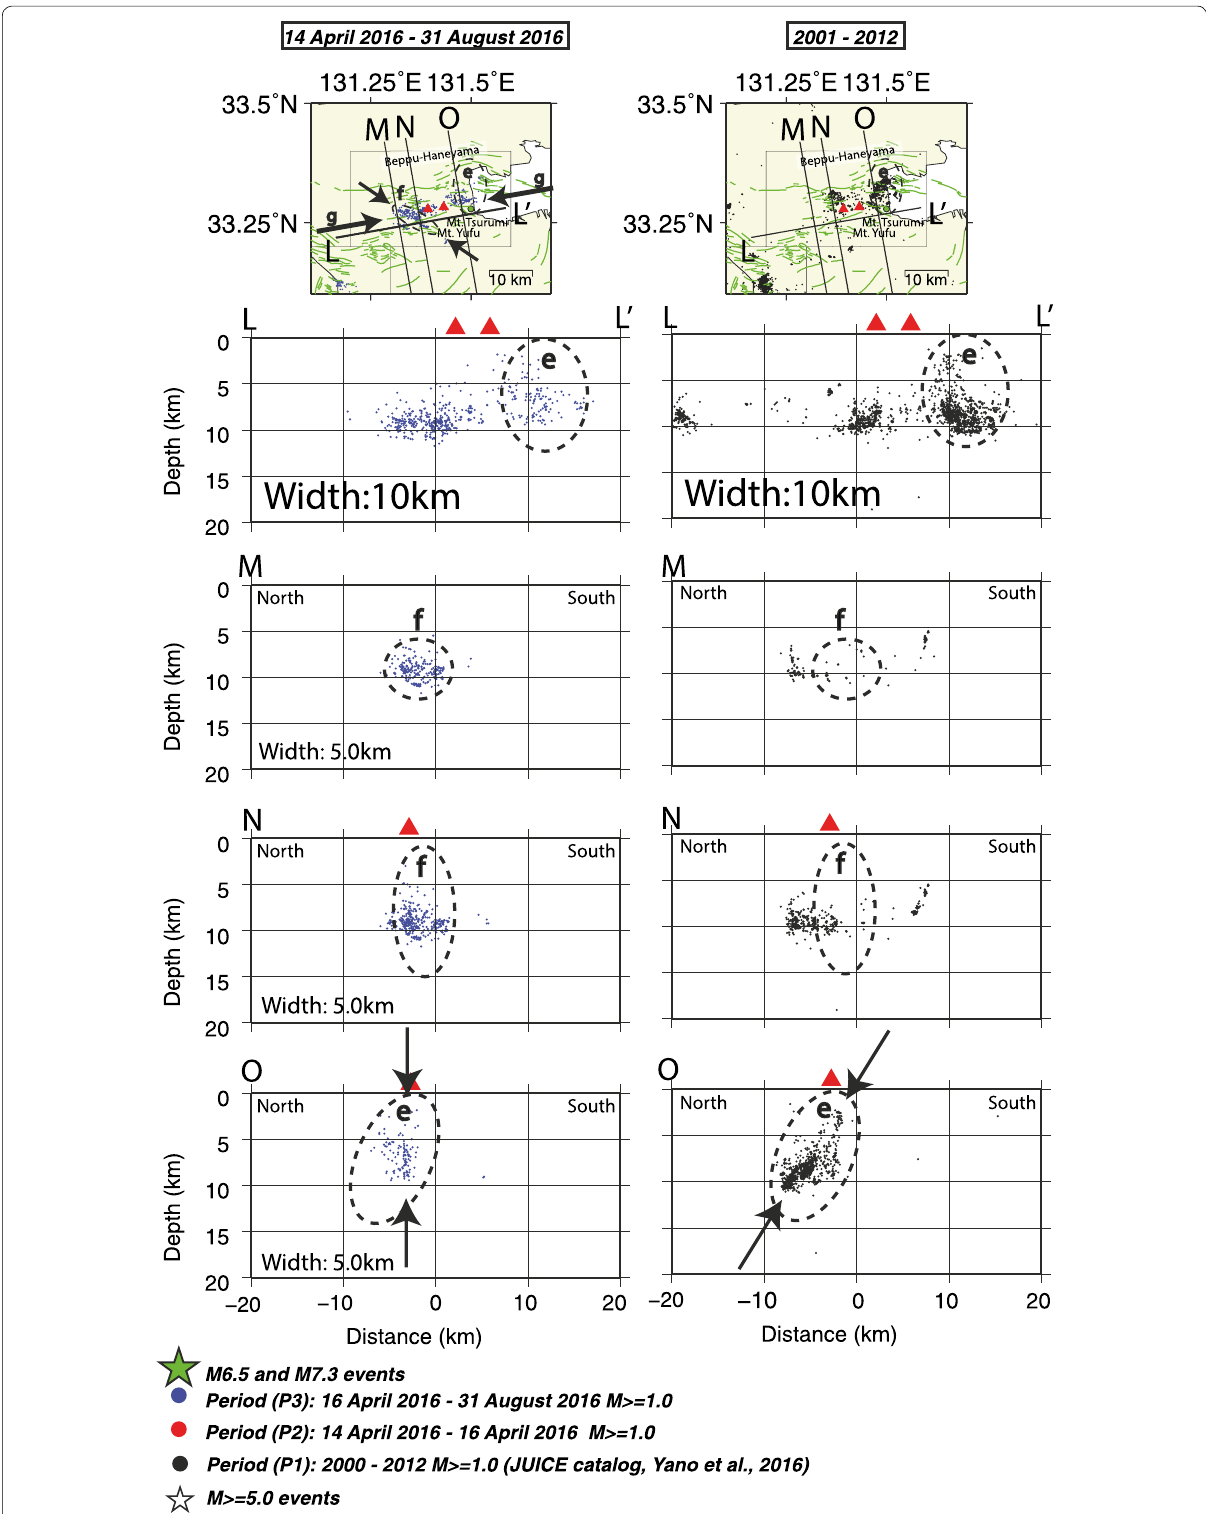
Fig. 4 Relocated hypocenters distribution and cross sections accompany the relocated hypocenter of 2001–2012 in the right column within the subregion (SR5). This cross section follows the Beppu–Haneyama fault